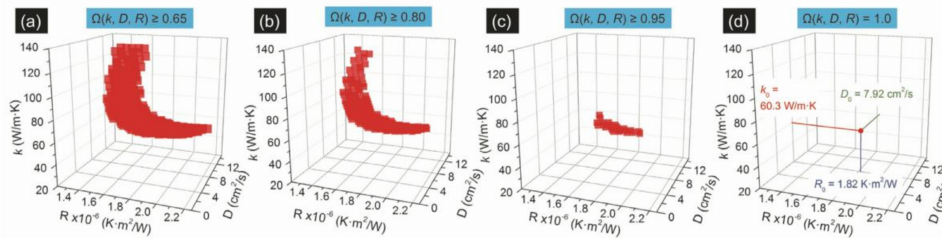
Figure 9. The evolution of distribution of Ω ( κ , D , R ) . ( a ) Ω ( κ , D , R ) ≤ 0.65; ( b ) Ω ( κ , D , R ) ≥ 0.80; ( c ) Ω ( κ , D , R ) ≥ 0.95; ( d ) Ω ( κ , D , R ) = 1.0. Reproduced from Ref. [51] with permission from the Royal Society of